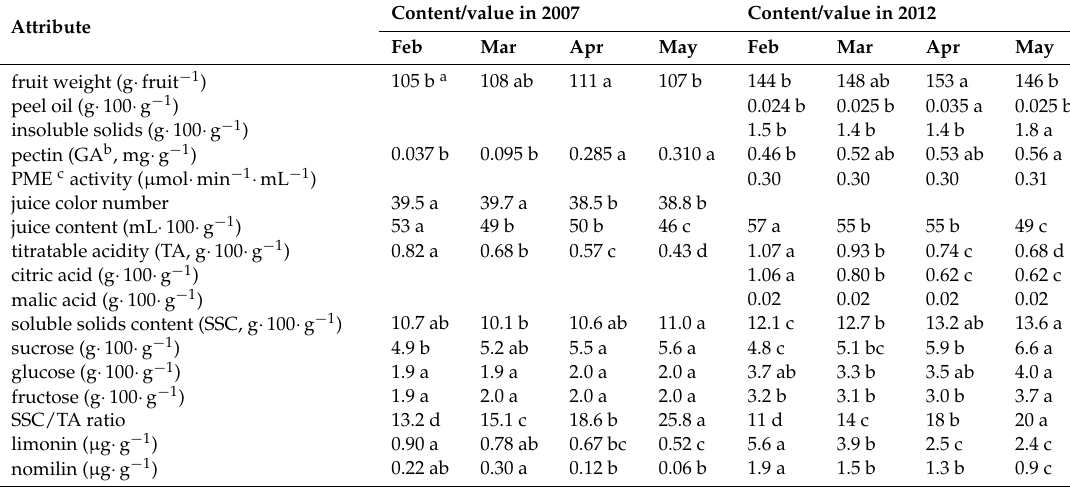
Table 1. Changes of the basic fruit/juice properties, and non-volatile and mouth feel related attributes including fruit size, peel oil, insoluble solids, pectin, activity of pectin methylesterase (PME), juice color number, juice content, titratable acids (TA), citric acid, malic acid, soluble solids content (SSC), sucrose, glucose, fructose, SSC/TA ratio, limonin and nomilin in “Valencia” orange fruit/juice extracted from fruit harvested in March to June 2007 ( n = 5) and February to May, 2012 ( n =